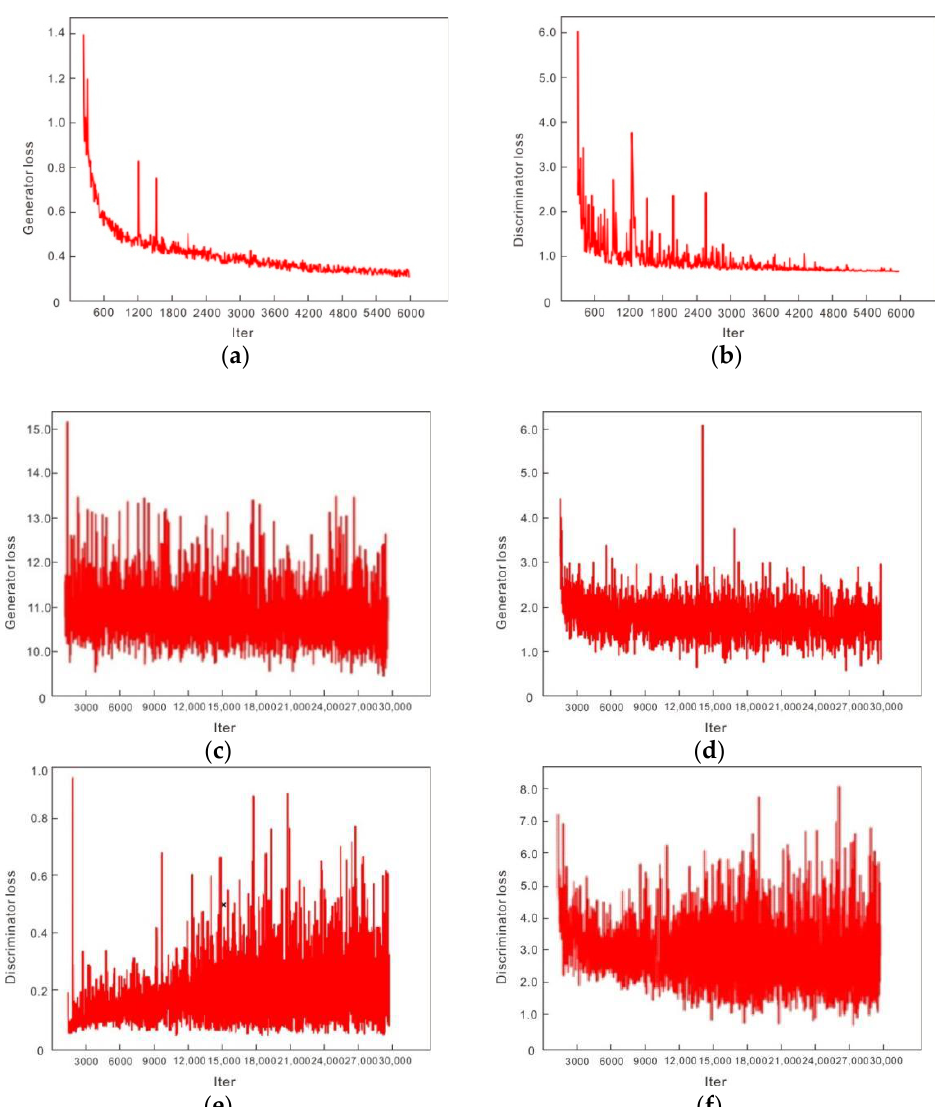
Figure 12. Training loss comparison of each network. The smaller the probability that false data were judged as false by the discriminator, the better the probability that the false data generated by the generator tended to real data. The two fought against each other and finally maintained a relatively stable range. ( a ) During CycleGAN network training, the number of iterations was 6000; the generator loss decreased significantly; and tended to be stable with the increase in iterations. ( b ) During CycleGAN network training, the number of iterations was 6000, and the loss in the discriminator decreased with the increase in the number of iterations and finally oscillated in a stable range. ( c ) During U-GAT-IT network training, the number of iterations was 30,000 and the generator loss oscillated in a stable range of 10 – 14. ( d ) During U-GAT-IT network training, the number of iterations was 30,000 and the loss in the discriminator oscillated in a stable range of 1 – 3. ( e ) In the process of Lapstyle network training, the number of iterations was 30,000 and the generator loss fluctuated in a stable range of 0 – 0.6. ( f ) During Lapstyle network training, the number of iterations was 30,000 and the generator loss oscillated in a stable range of 1 – 6.